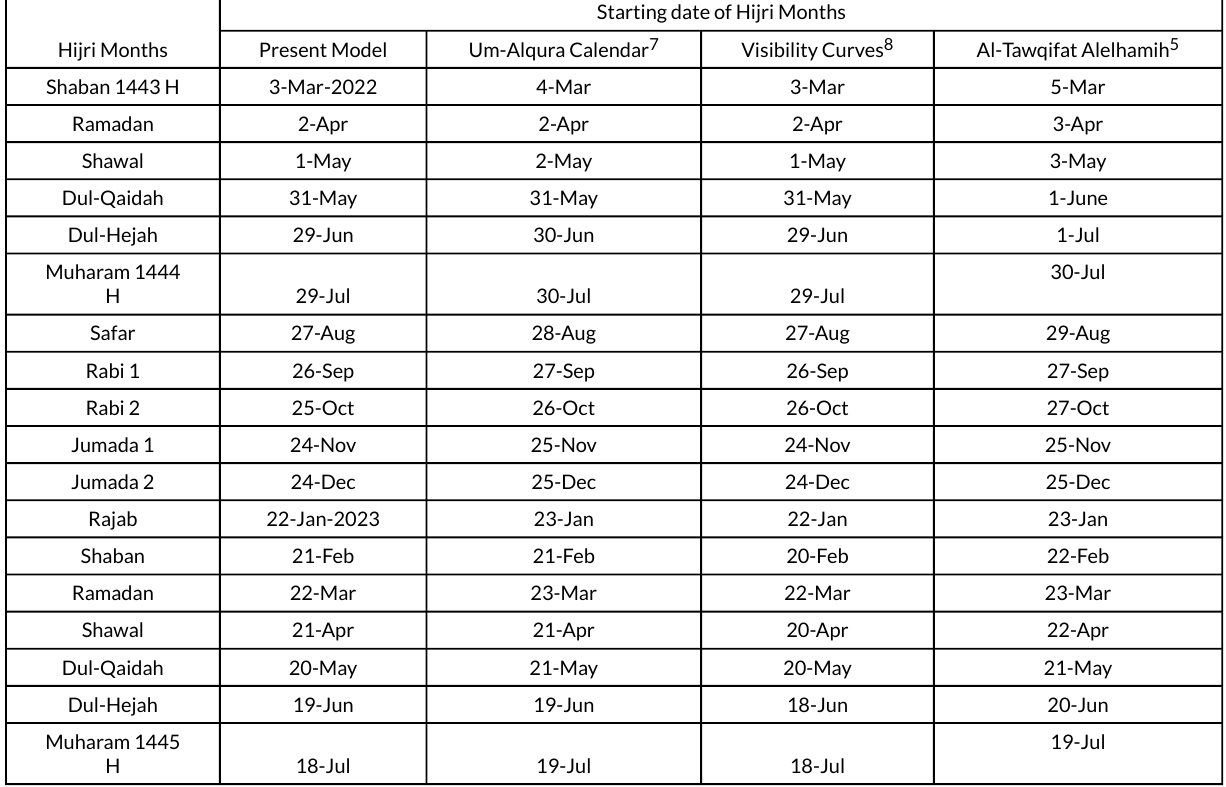
Table 1. The results of the present model Vs 3 references.